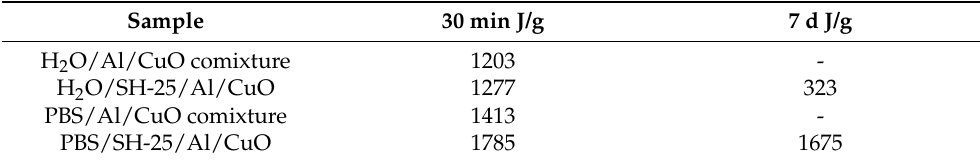
Figure 7. Heat release DSC plots of nanothermites. ( a ) Al and CuO assembled for 30 min. ( b ) Al and CuO assembled for 7 d. Table 1. The total heat energy ( ∆ H) released by nanothermites.